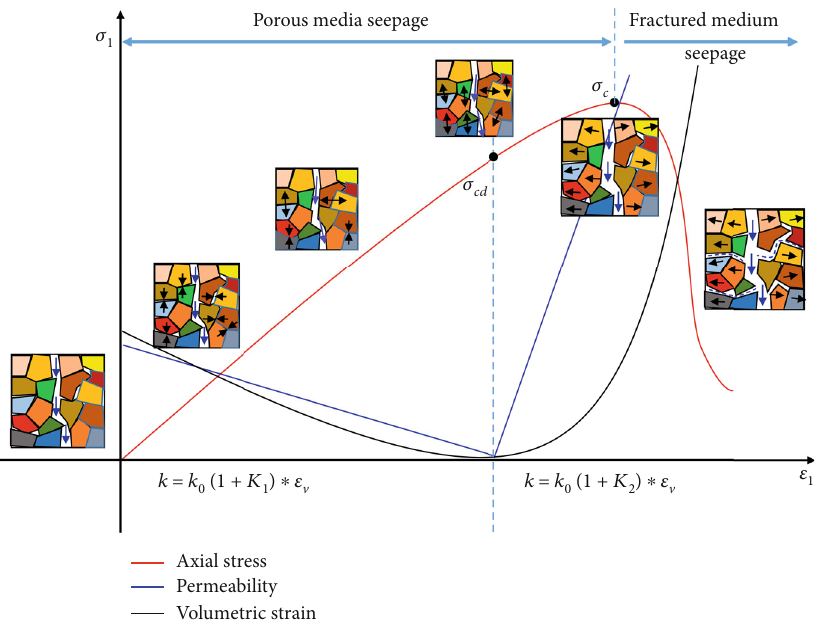
Figure 6: Simpli fi ed illustration of permeability evolution in HM coupling processes in Beishan granite.